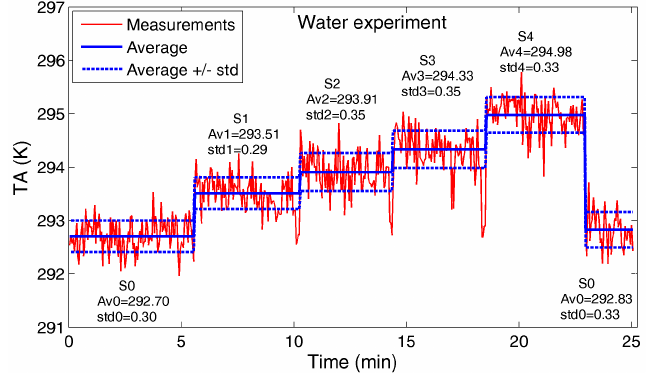
Figure 6. Water experiment: antenna temperature T A measured by the radiometer. For each setting (S0, S1, S2, S3 and S4), average (AvN) and standard deviation (stdN) are reported in Kelvin. The T A mean increment is around 0.8 K adding the first water bin (S1), and in the range 0.4–0.65 K adding each bin in sequence.